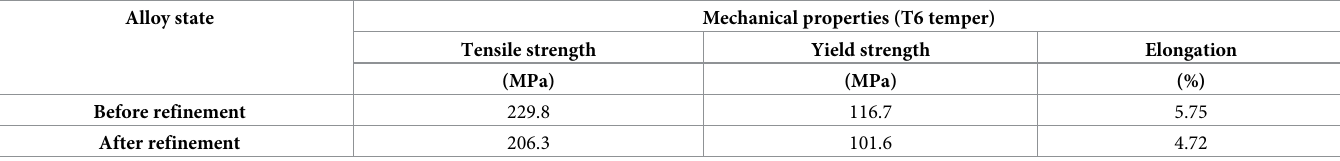
Table 2. Effect of refinement on the mechanical properties of AZ91 alloy. Alloy